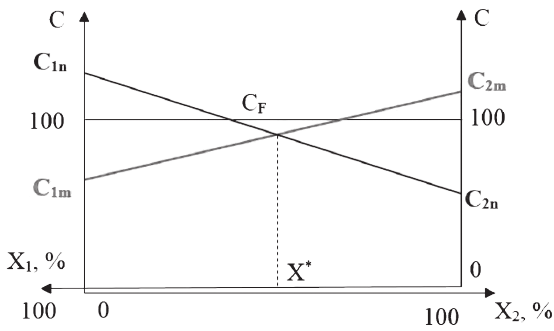
Figure 1 Changes in limiting amino acid scores in binary compositions depending on the X /X ratio [5]. The C – C 1 2 2m 1m line (red) is the changing score of the limiting m -th amino acid; the C – C line (blue) is the changing score of the 2n 1n limiting n -th amino acid; C is the ‘ideal’ protein score; X* F is the optimal ratio of components corresponding to C*, the maximum score of the